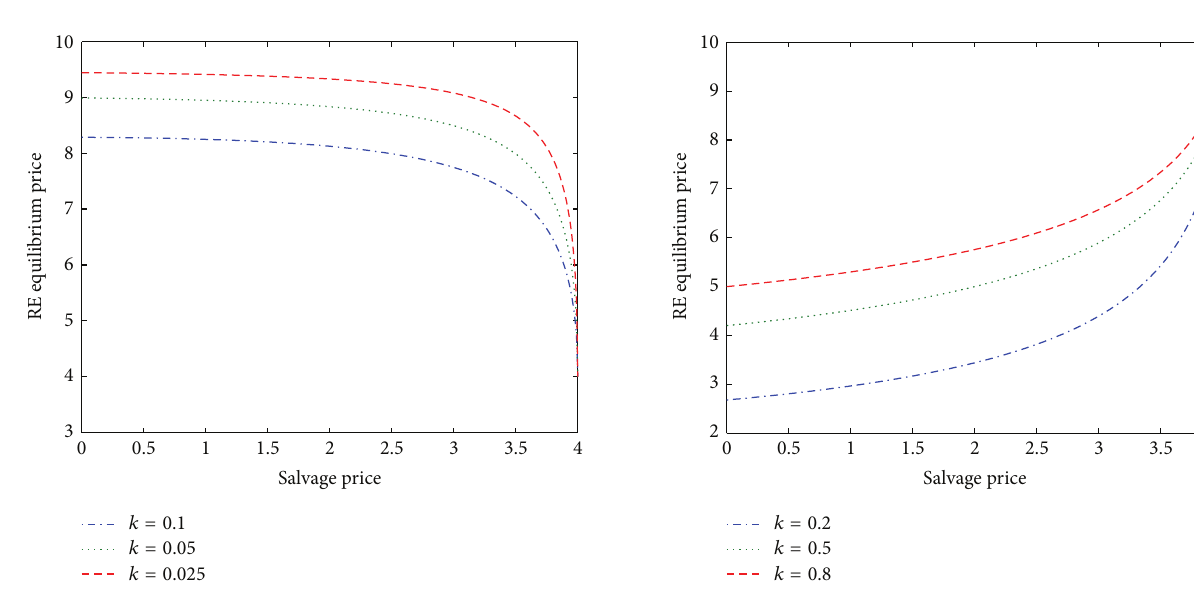
Figure 5: The effect of salvage price on 𝑄